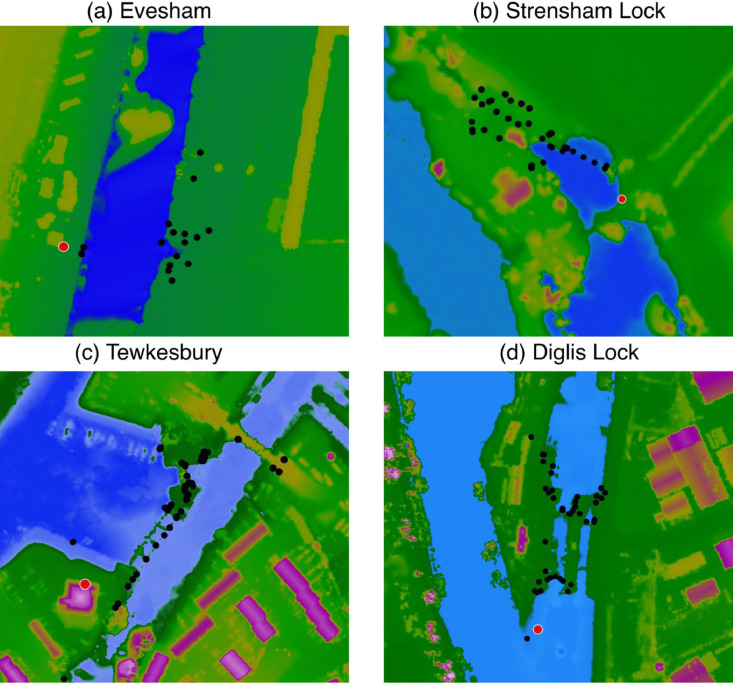
Locations of metadata points for the four river cameras using both the Total Station and the GNSS instruments. The red dots are the camera locations and black dots are the various field-of-view points seen through the cameras. Point data is plotted on the Environment Agency lidar data of 1 m resolution (lidar data can be found here: https://environment.data.gov.uk/DefraDataDownload/?Mode=survey). Use the following references for each of the cameras: sp04sw for Evesham, so94sw for Strensham Lock, so83se for Tewkesbury, and so85sw for Diglis Lock. Note that the colourbar is different for each of the images and since it is irrelevant is not displayed here. Plots made using Landserf Version 2.3. http://www.landserf.org[12]. (For interpretation of the references to colour in this figure legend, the reader is referred to the web version of this article.)